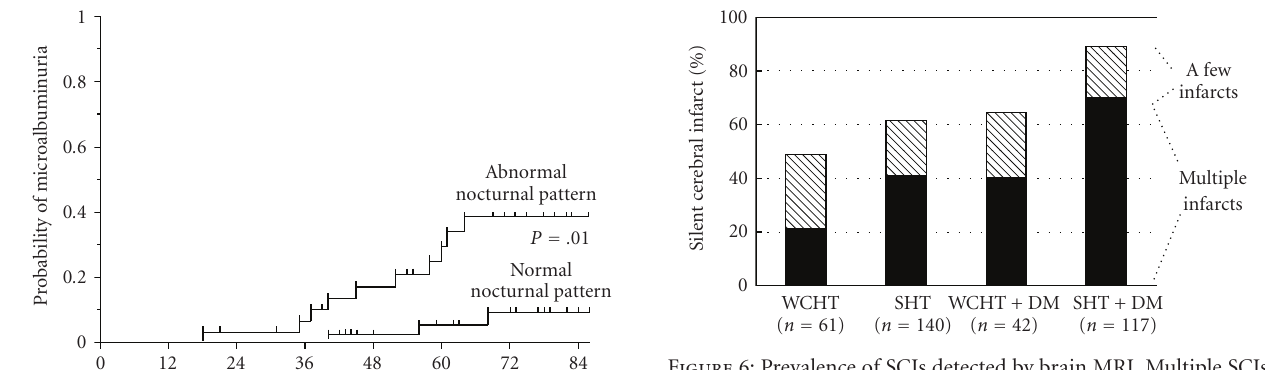
Figure 6: Prevalence of SCIs detected by brain MRI. Multiple SCIs are defined as ≥ 3 infarcts per person. The overall probability values for 4-group comparisons were determined by chi-square test as shown in Table 1 (adopted from